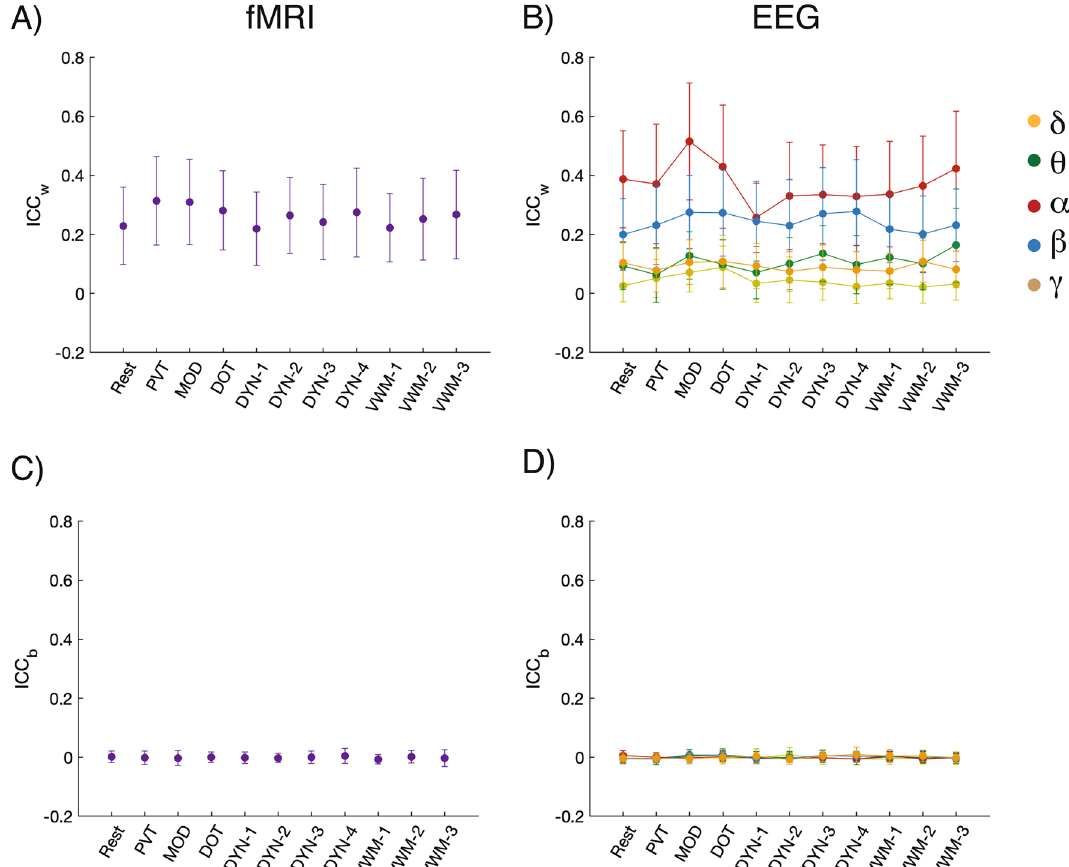
Figure 2. Reliability of individual connections (A and B) within-subjects (ICC w ) and (C and D) between- subjects (ICC b ) for fMRI and EEG frequency bands across tasks: DOT, PVT, MOD, VWM-1:3, and DYN-1:4. For each plot, the figure shows the mean and standard deviation. DOT dot probe task, DYN dynamic attention task, MOD modular math task, PVT psychomotor vigilance task, VWM 1–3 visual working